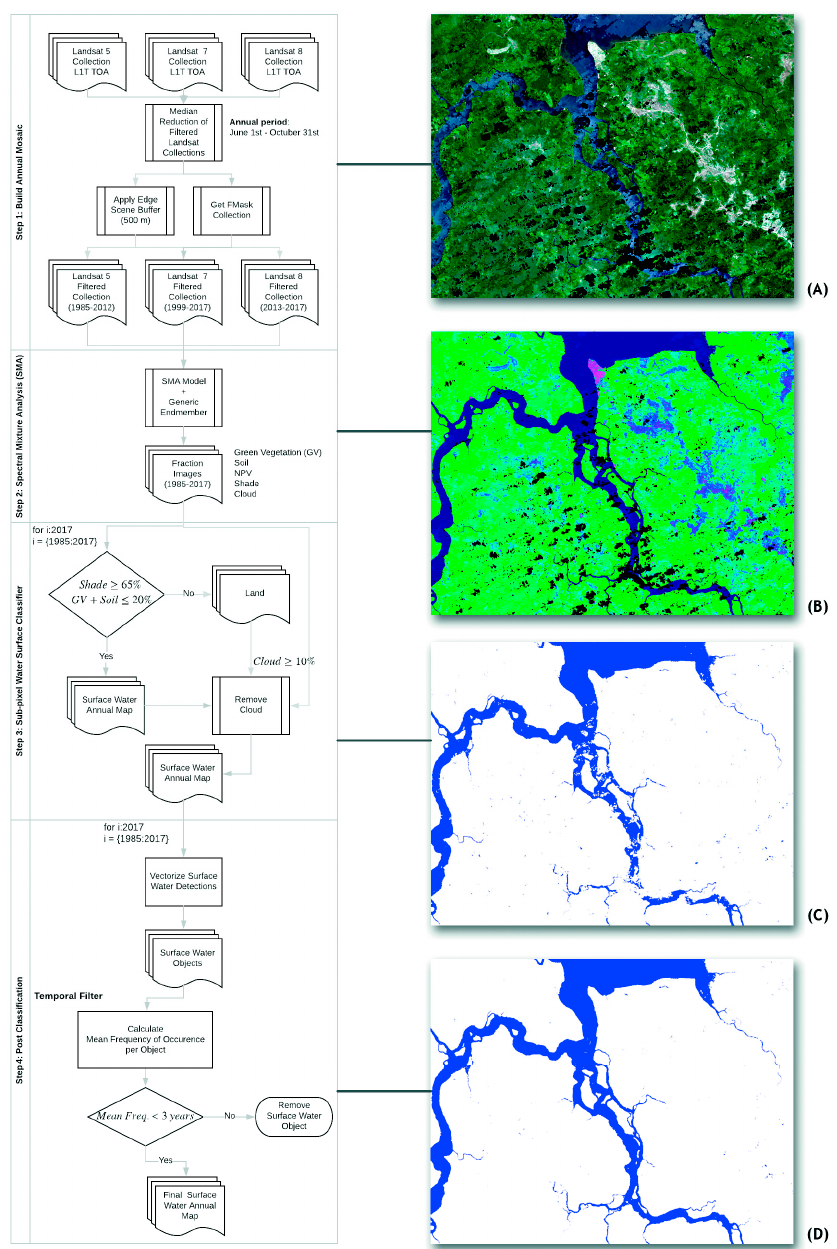
Figure 2. Image processing applied to annual Landsat datasets acquired between June and October to derive surface water maps, ( A ) annual median mosaic ( B ) SMA color composite (Red—Soil, Green—Green Vegetation, Blue—Shade), ( C ) surface water classification, and ( D ) temporally filtered surface water.